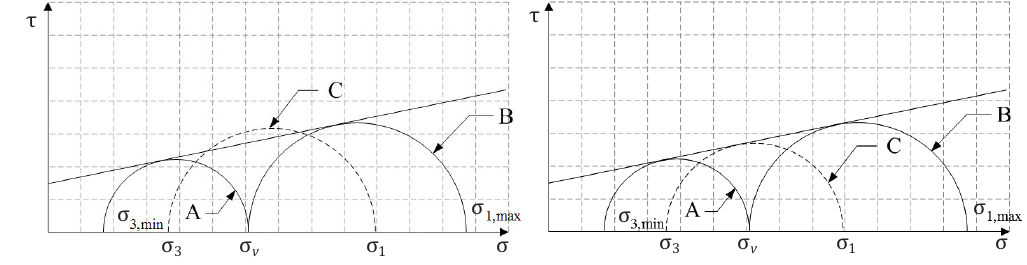
c) the stress state 2 before the correction d) the stress state 2 after the Figure 5. Plots of the stress correction used in the MICH-PAVE program (Raad & Figueroa, 1980)